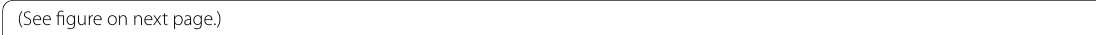
(See figure on next Fig. 4 LDs accumulation in neuron. To detect LDs accumulation in the hippocampal neurons, Nile red (red) and DAPI (blue), BODIPY (483/503) (green) and NeuN (red) were used. A LDs accumulation could be detected (red, black arrow) in the WT CIH mice, and treated with SMND-309 + decreased this change. B Abundant BODIPY (483/503) fluorescence could be detected in the neurons of the DG area under CIH condition, but the fluorescence became dim after SMND-309 treatment. C Quantification of LDs accumulation in nerve and glia cells. D Quantification of LDs accumulation in neurons. *p < 0.05 WT group vs. WT CIH group. **p < 0.05 WT CIH group vs. SMND-309 CIH group. All experiments were repeated three times. Data are shown as the mean SEM. Statistical analysis was tested by two-way ANOVA. Original magnification: 400 ± ×